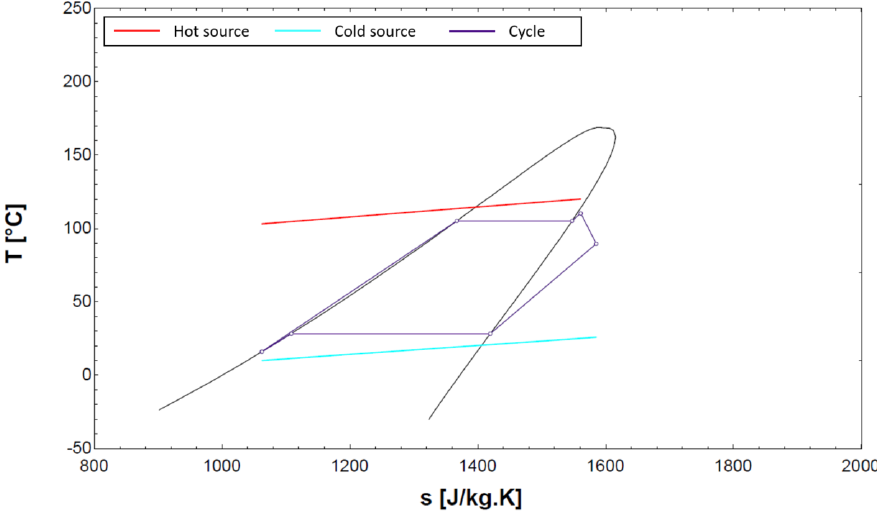
Figure 1. ORC (Novec649 TM ).